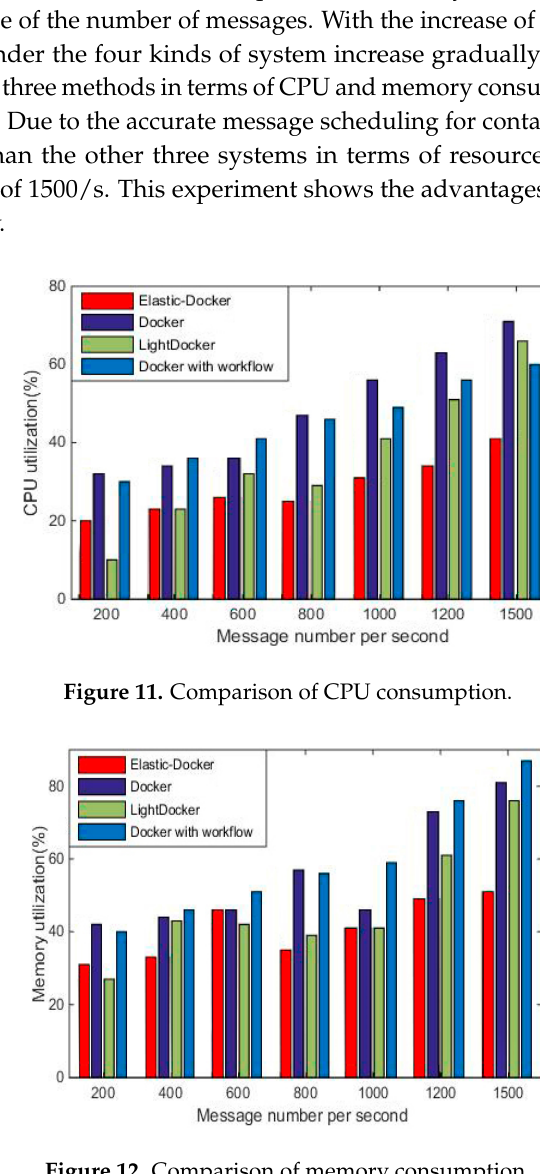
Figure 13. Comparison of scalability. In the case of high concurrent applications, frequent changes in workload led to the pressure of the container, and also frequent changes, so it can effectively test the elasticity in this environment. With the increase of hosts in the container cluster, the elasticity is 60% higher than the original Docker